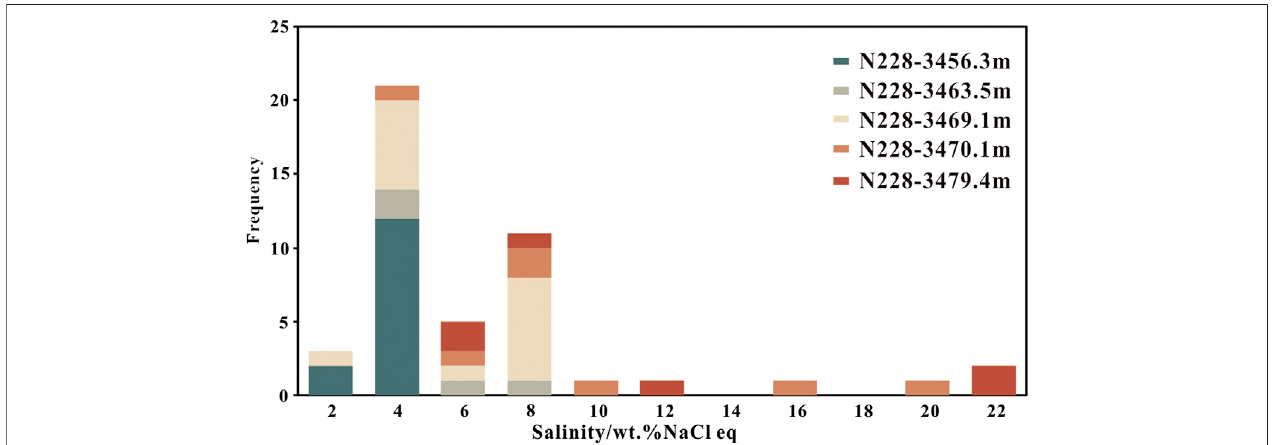
FIGURE 7 | Salinity histogram of well N228 in the Changning area, southern Sichuan Basin.